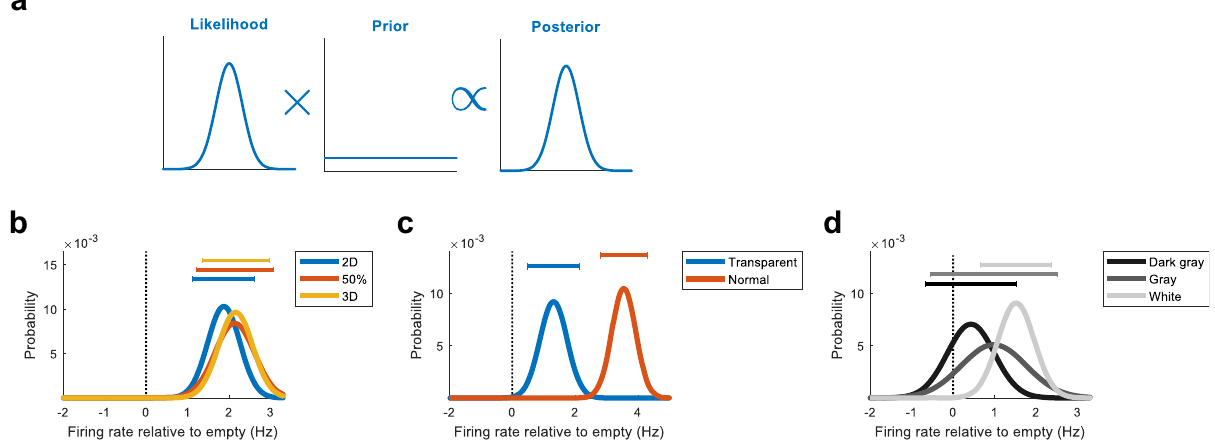
Fig. 5 Posterior probability distributions of the average fi ring rates of OV cells to each object or feature. a Visualisation of Bayesian inference. Bayes ’ theorem multiplies the likelihood with a prior to give the posterior distribution summarising our state of knowledge. The likelihood shows which average fi ring rates (FRs) best explain the data obtained. The prior gives the probabilities of different fi ring rates before seeing the data. The resulting posterior shows the probability that OV cells respond with any average FR to the object. For the distributions in Fig. 5, we assigned a Gaussian likelihood and assumed a uniform prior (see 'Methods' for details). We veri fi ed that our conclusions were insensitive to these assumptions (Supplementary Figs. 7 and 8). b Posterior distributions showing the probability that OV cells respond with any average FR to each object. The plots correspond to Fig. 2 and describe the results for the 2D surface (blue curve), the partially embedded object (red curve) and the 3D object (yellow curve). The data are the fi ring rates of OV cells inside the region in which we expect each cell to fi re based on its vector coordinates. The fi ring rate in the same region in the ‘ Empty Box ’ trial has been subtracted. This means that probability on the right (left) of 0 Hz should be interpreted as a positive (negative) response to the object. 0 Hz is marked by the stippled line. The intervals at the top represent the ‘ credible region ’ , which is the smallest possible region containing 95% of the probability mass. The credible region can be interpreted as ' ‘ there is a 95% probability that OV cells respond with an average FR between these bounds ’ . c Same as in the previous panel but probability distributions corresponding to Fig. 3 describing the results for the transparent surface (blue curve) and normal 3D tower (red curve). d Same as in the previous panels but probability distributions corresponding to Fig. 4 describing the results for the dark grey, grey and white contrast. Note that while all curves peak at positive values, the right-shift of the curves increases gradually with increasing visual